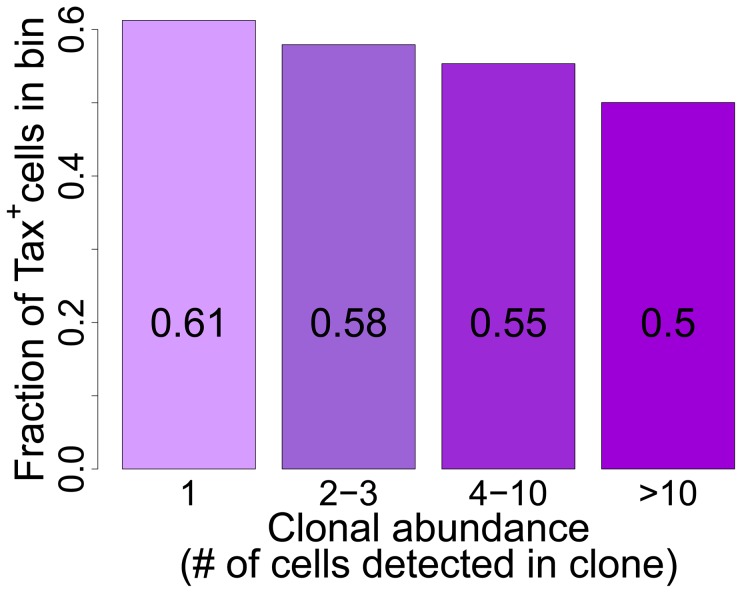
Tax+ cells are more frequent in smaller clones.Mean fraction of Tax+ cells in bins of increasing clonal abundance (total number of cells in each respective clone). The fraction of Tax+ cells was negatively correlated with clonal abundance (p<10−16, χ2 test for trend).